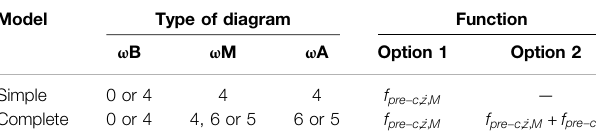
TABLE 10 | Rules for modeling the SA characteristic diagrams.